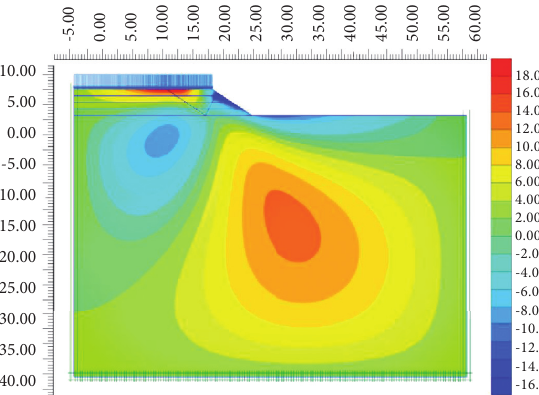
Figure 4: Horizontal displacement cloud map.